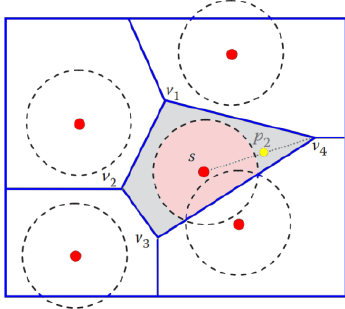
Figure 2. Coverage hole (gray regions) in a WSN overlaid on the Voronoi diagram of the sensors The VOR is a pulling strategy so that sensors cover their local maximum coverage holes. In this algorithm, each sensor moves toward its furthest Voronoi vertex till this vertex is covered (Figure 3).